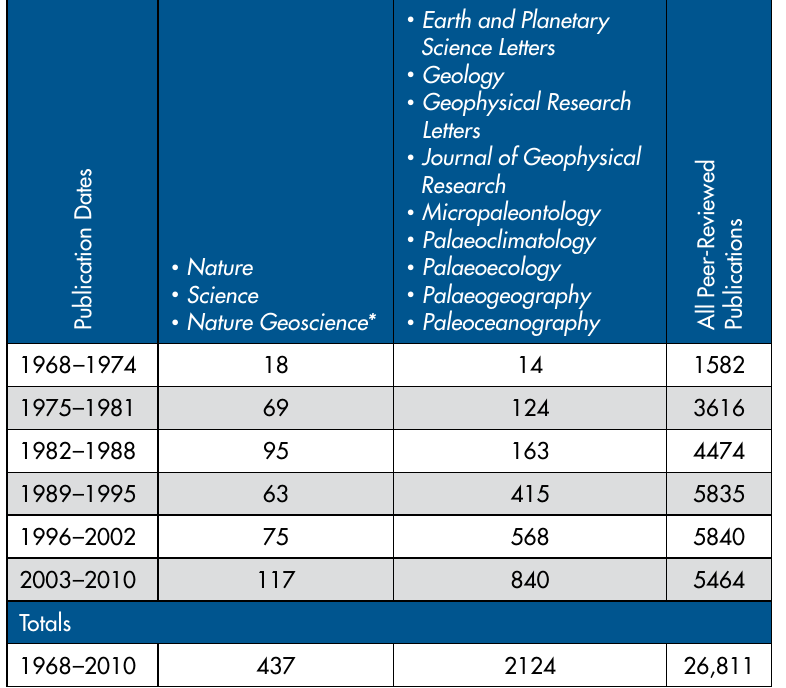
Table 1.1. list of